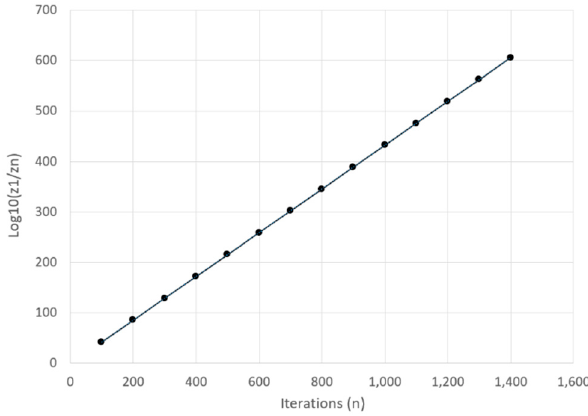
Figure 9. Log( z R ) vs. iterations. Figure 9. Log( 𝑧 (cid:3019) ) vs. iterations. Table 1. Data obtained using Matlab and